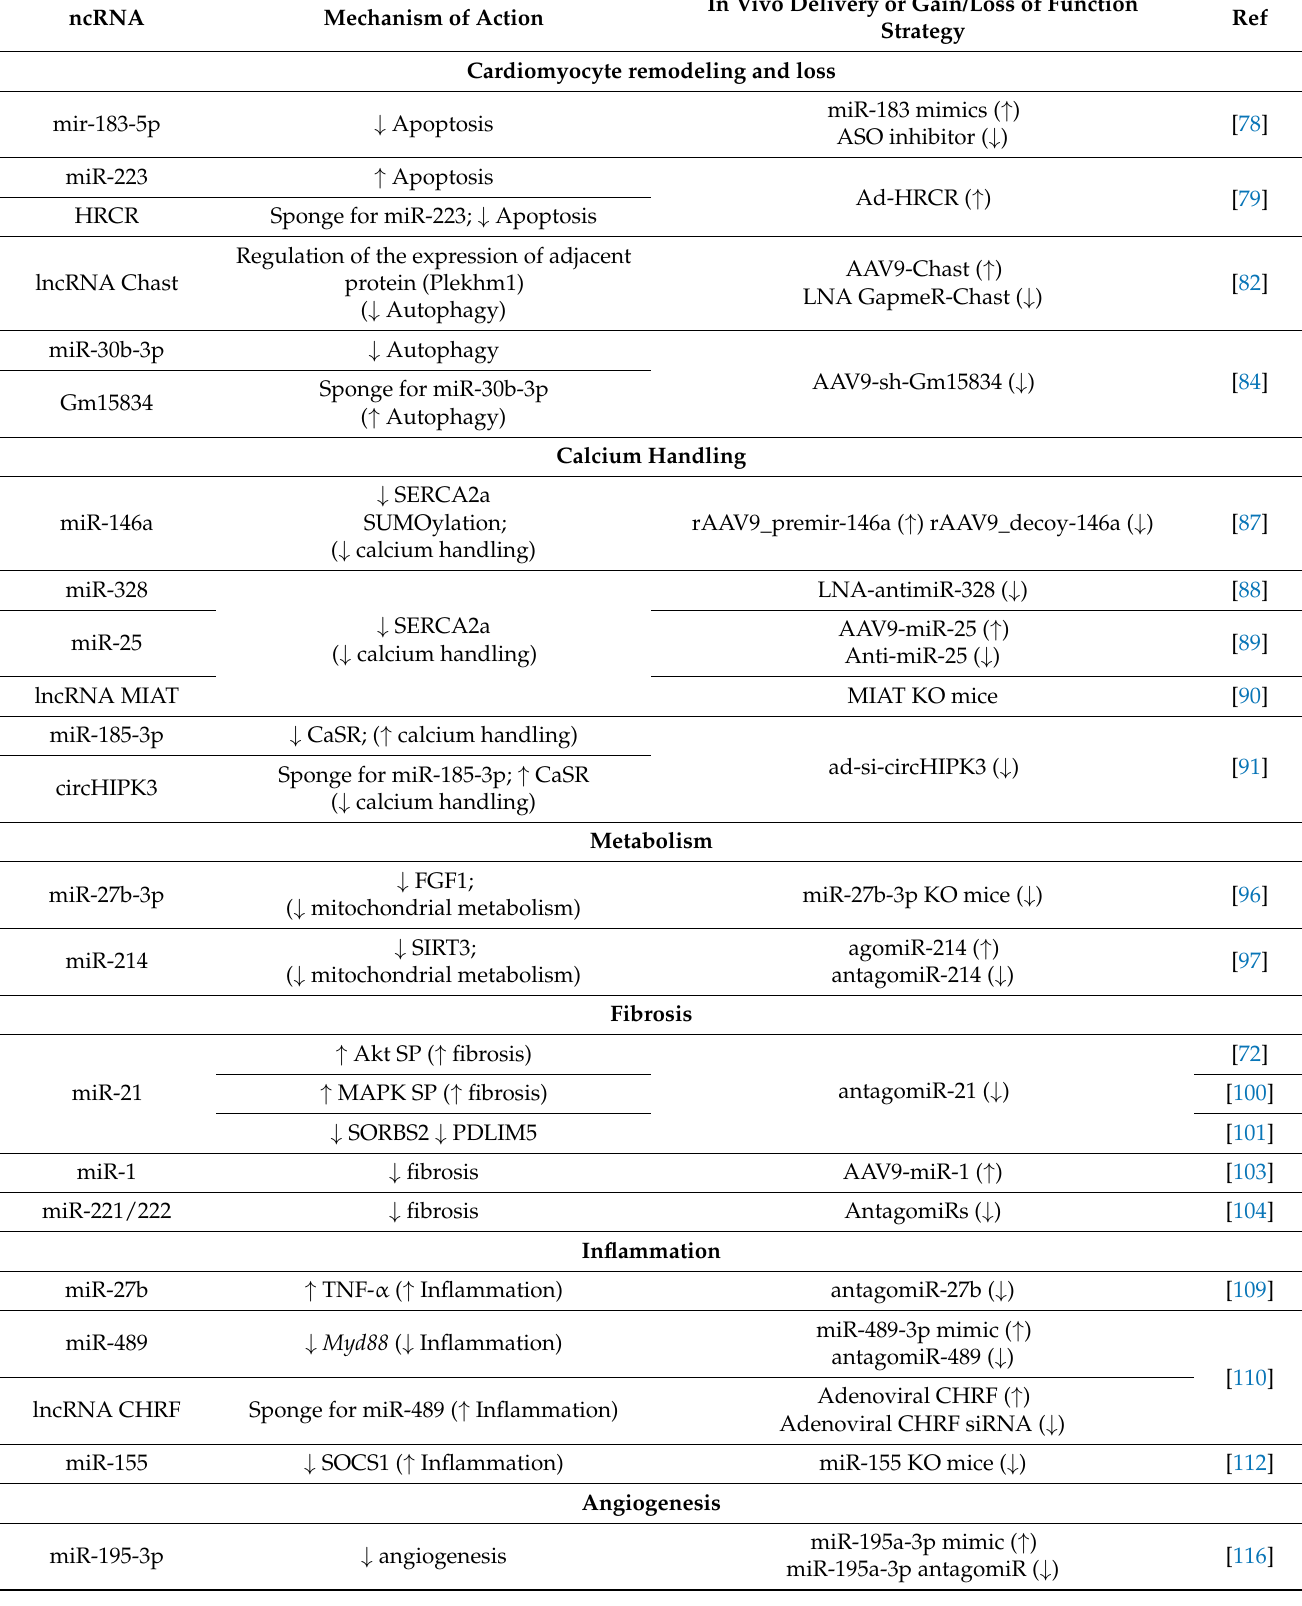
Table 3. Overview of the ncRNAs reported to be specifically involved in the pathophysiological mechanisms inherent to cardiac